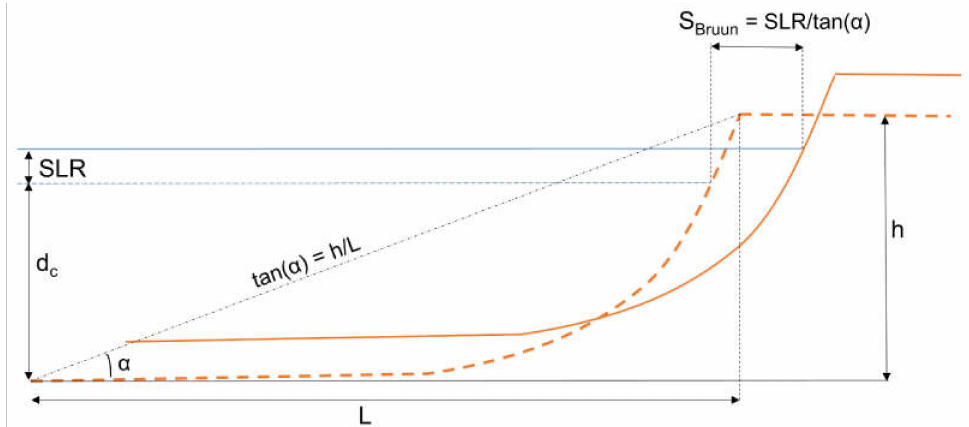
Figure 2. Schematic of the original Bruun model, where: SLR is the sea-level rise and S Bruun the respective shoreline recession over the considered time lap; h and L are, respectively, the vertical and cross-shore extent of the active beach, delimited seaward by the depth of closure (d c ) and landward by the berm, dune toe or dune crest; and tan( α ) is the average slope of the active beach